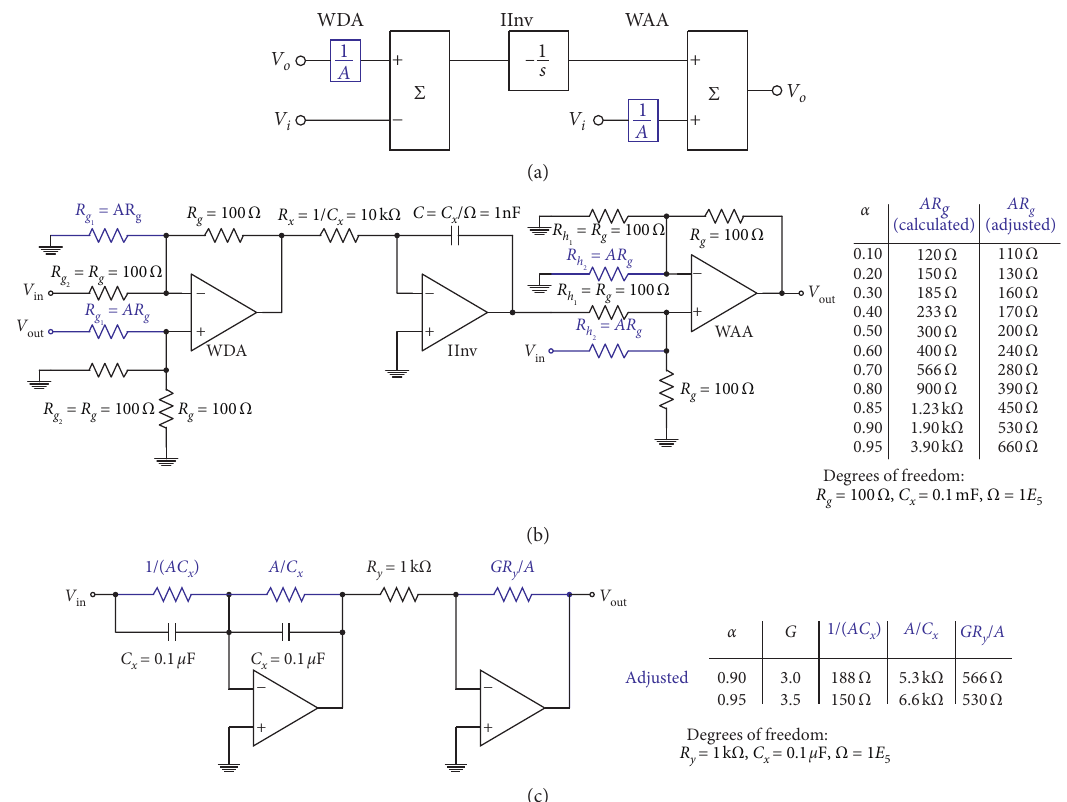
Figure 3: Fractional-order integrator. (a) Block diagram. (b) First implementation. (c) Second